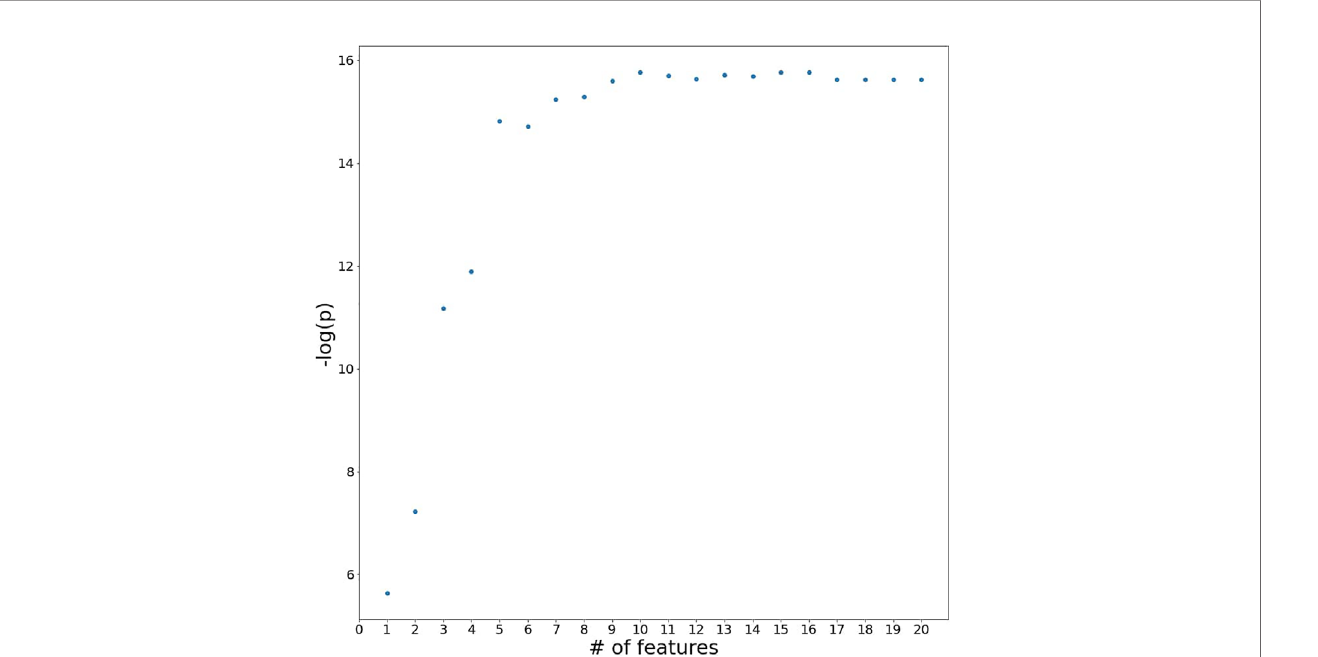
FIGURE 2 | A plot of P-values for testing the difference between the scoring system and the ground truth label ’ s group by adding the blood features to the system in the most important